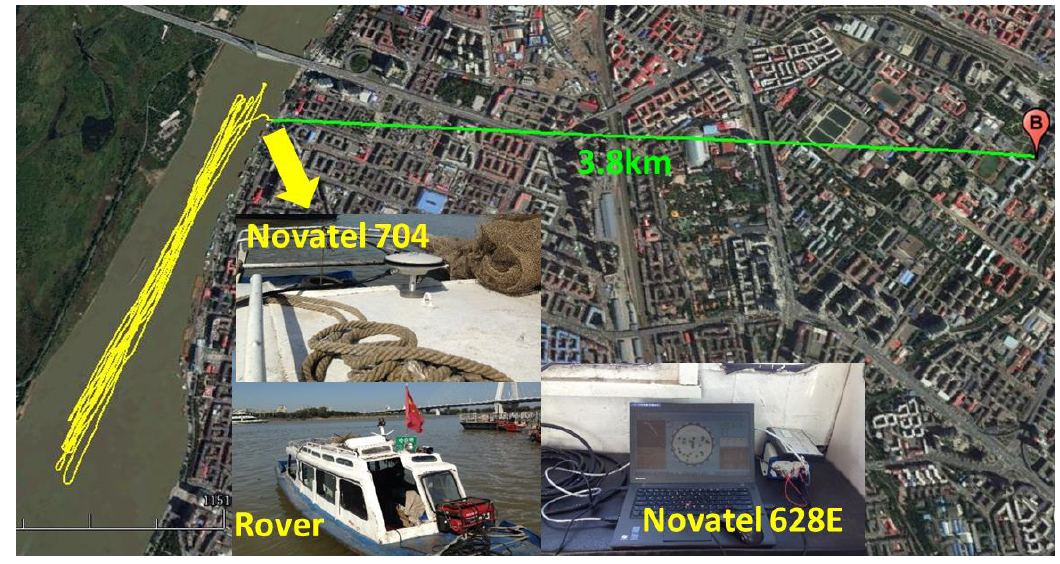
Figure 12. Kinematic experiment trajectory.